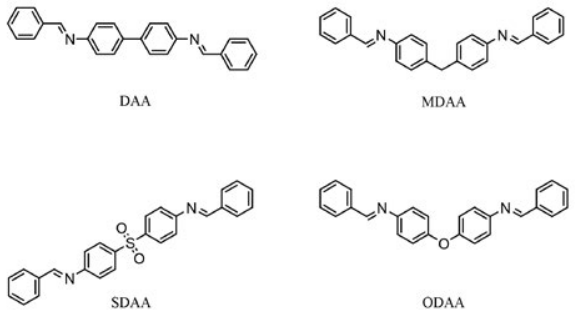
Figure 1: Chemical molecular structures of the studied dianiline Schiff